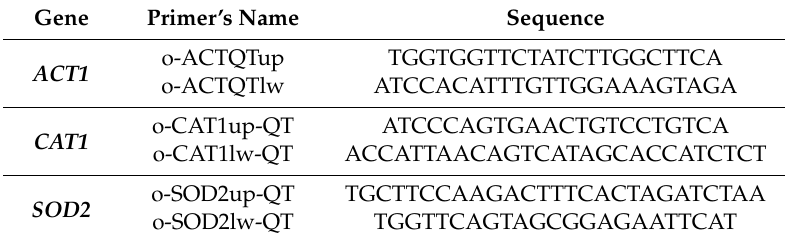
Table 1. Primers used for RT-qPCR